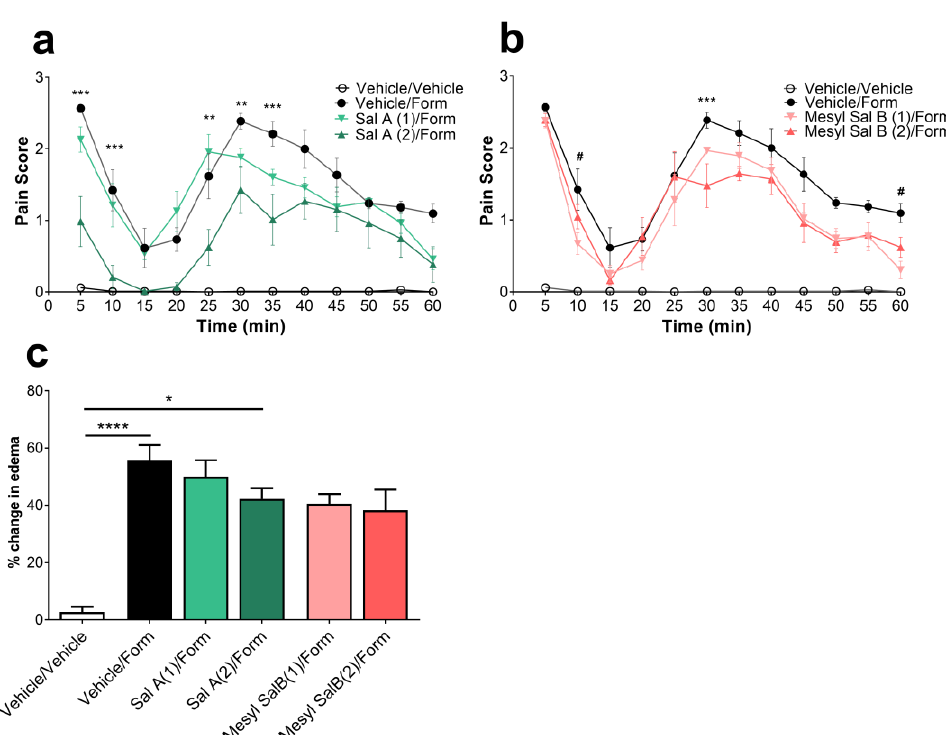
Figure 4. ( a ) The effects of Sal A and ( b ) Mesyl Sal B on phase 1 nociceptive pain (1 – 15 min) and phase 2